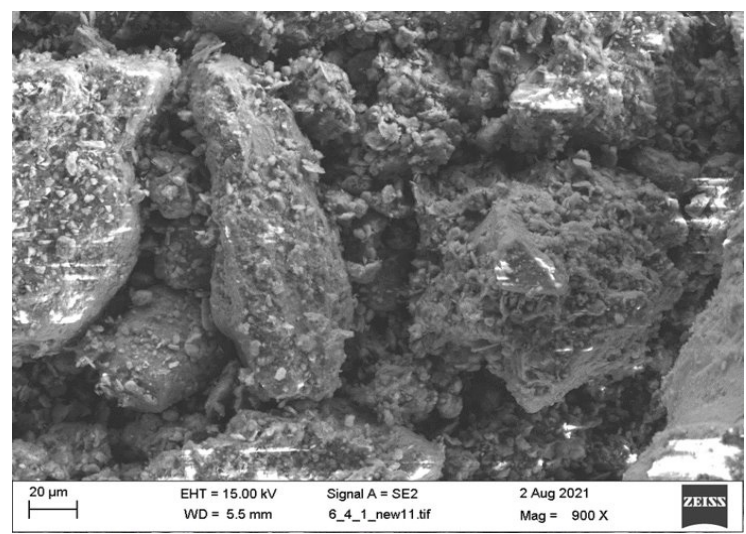
Figure 3. SEM image of raw clay.